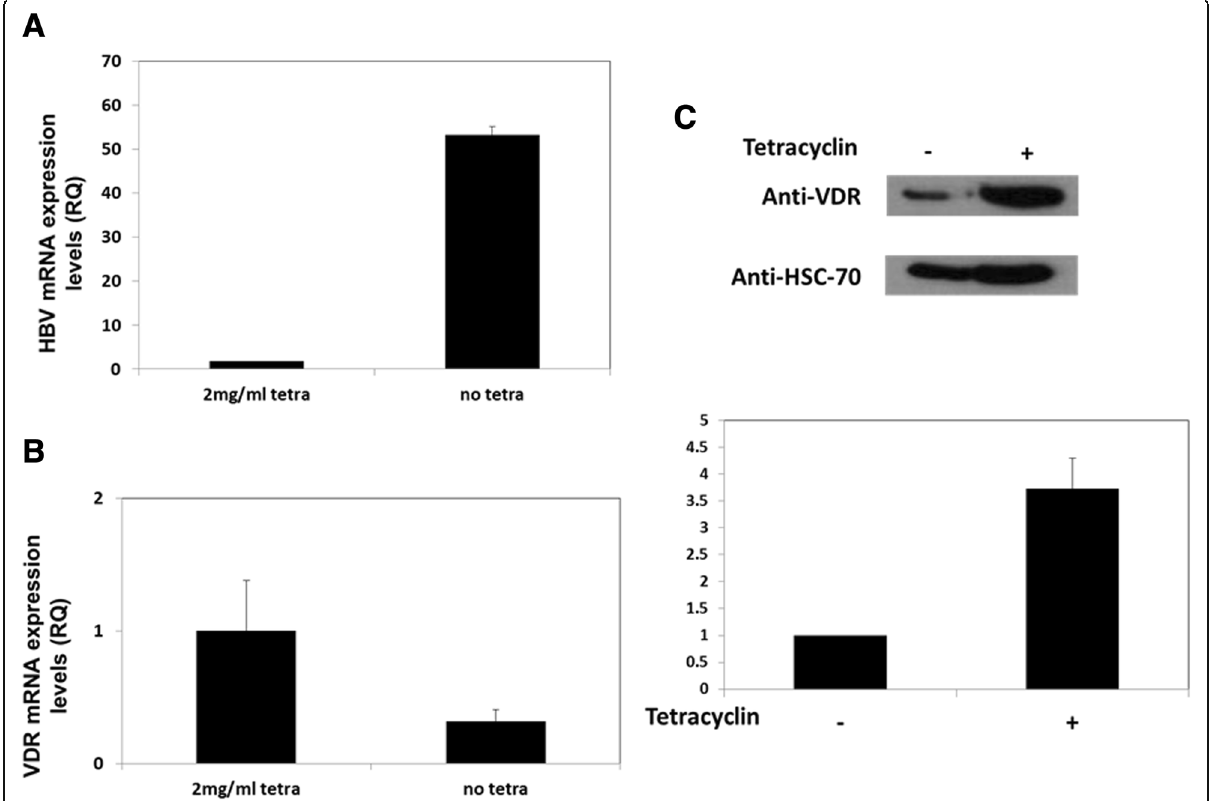
Fig. 3 VDR transcript levels after the induction of HBV expression in HepAD38 cells. HepAD38 cell were cultured in the presence of 0.3 μ g/ml tretracyline. In the next stage, HepAD38cells were washed and the medium was replaced by tetracycline free medium. HBV ( a ) and VDR ( b ) transcripts levels were measured using RT-PCR. VDR protein levels ( c ) were measured using western blot analysis. The western blot presented in the figure is a representative of three different experiments; all of these experiments were calculated in the quantification. Results are expressed as mean±standard deviation